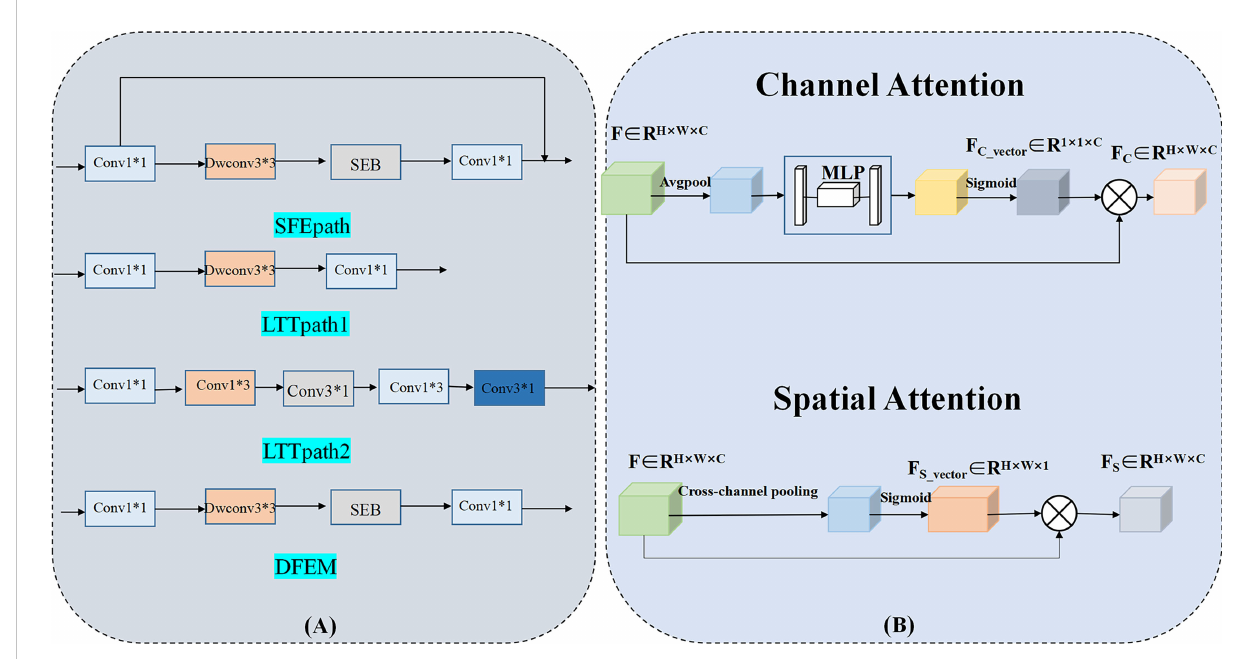
FIGURE 3 Three-branch structure and Cross-attention Module. (Conv, Convolutional layer; Dwconv, Depthwise convolutional layer; SEB, Squeeze-and- Excitation